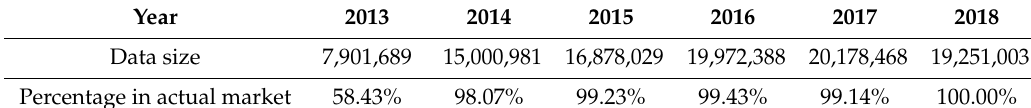
Table 1. Data sizes (vehicle numbers) for years 2013 to 2018.